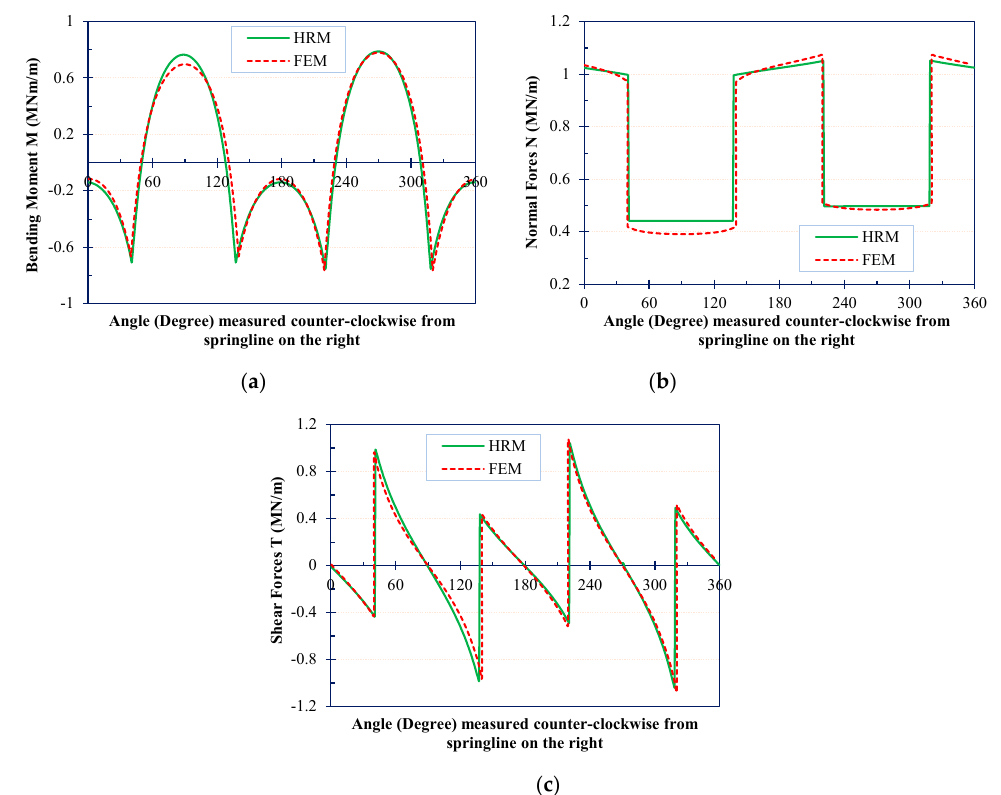
Figure 6. Internal forces in the rectangular tunnel lining: ( a ) Bending moments M; ( b ) Normal forces N; ( c ) Shear forces T.